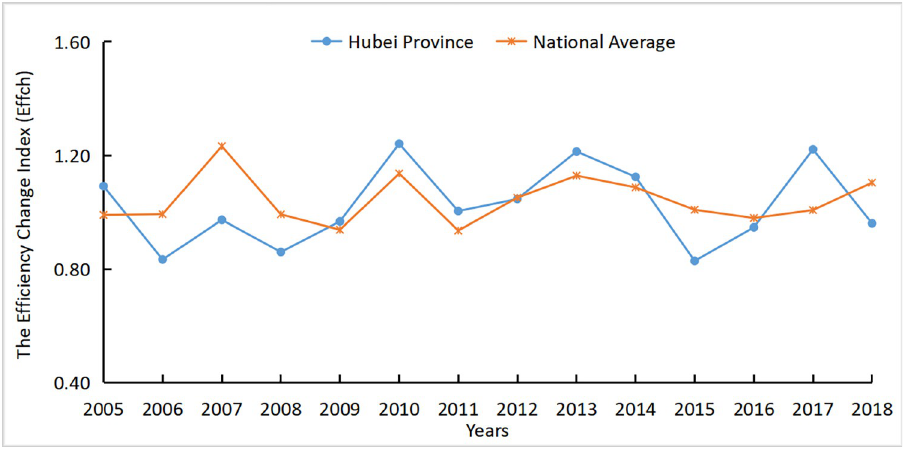
Fig 6. Effch index of Hubei Province and national average from 2004 to